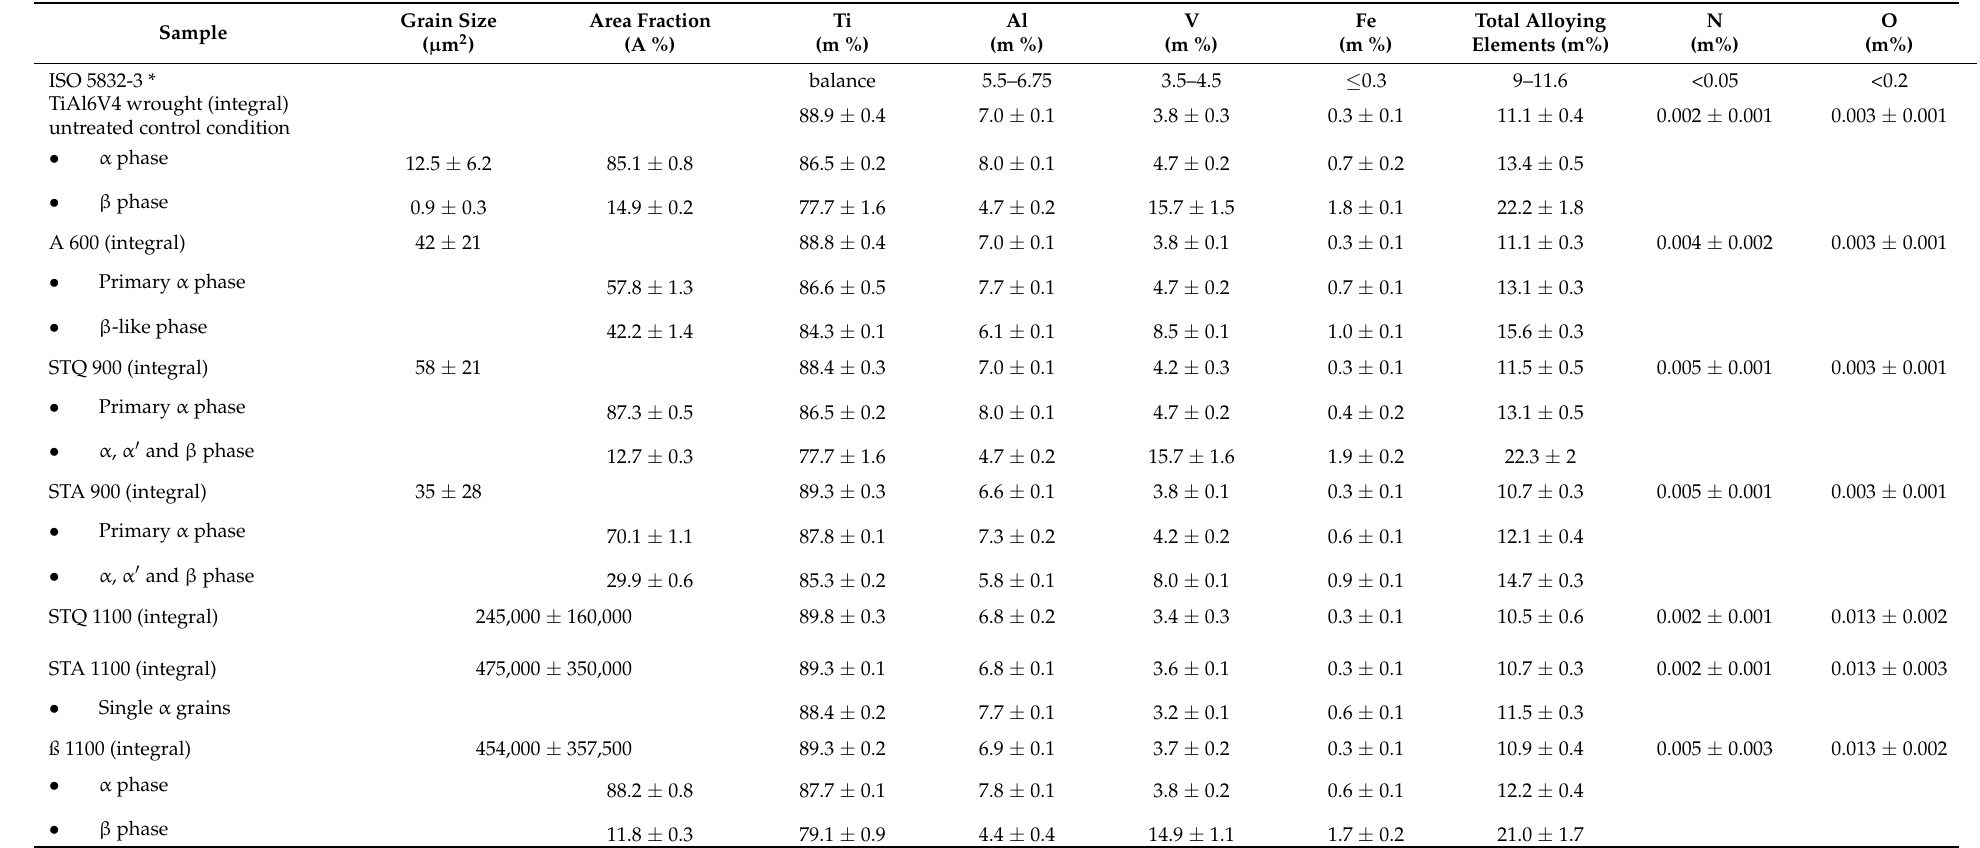
Table 2. Grain size ( µ m 2 ), area fraction (A %) and chemical composition (m %) of present microstructural constituents of different heat-treated TiAl6V4 samples determined for Ti, Al, V and Fe by EDS spot analysis. Integral value is measured over a sample area of 2 × 2 mm and integral N and O content is determined by gas melt extraction analysis (data as mean ± SD, n = 5 for EDS, n = 3 for gas analysis). A comparison with the chemical composition according to the ISO 5832-3 standard for wrought alloy TiAl6V4 surgical implants is provided